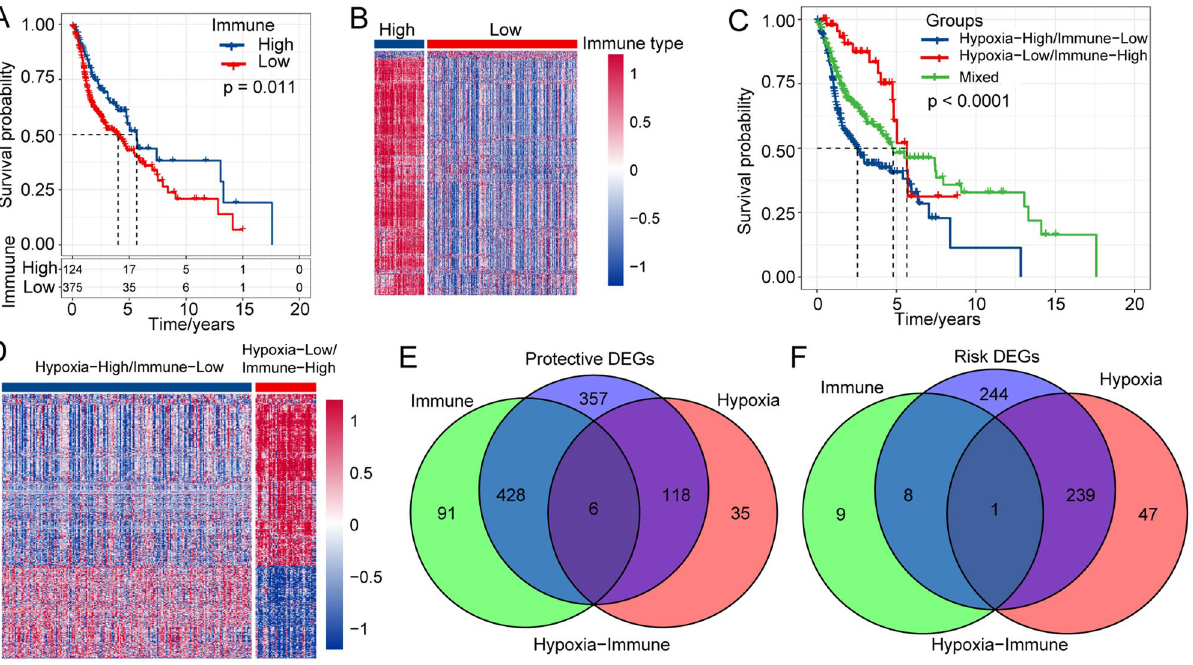
Figure 2. Identification of subgroups of hypoxic immune microenvironments. ( A ) Survival analysis of the immunization group. ( B ) Analysis of differentially expressed genes in the immunization group. ( C ) Survival curve of hypoxic immune microenvironment grouping. ( D ) Heatmap of differentially expressed genes among hypoxic immune microenvironmental groups, and R software v3.5.0 (version 3.6.1) was adopted to drawn the heat map. ( E ) Identification of protective differential genes. ( F ) Identification of risk differential